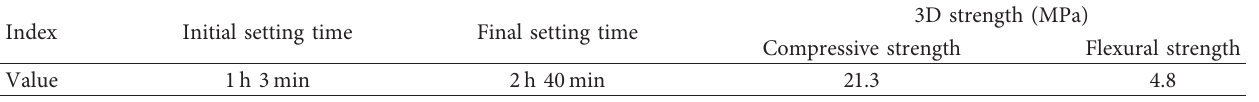
Table 1: Technical indexes of